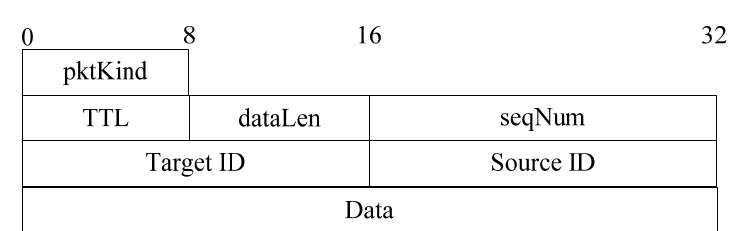
Figure 15. Format of data back